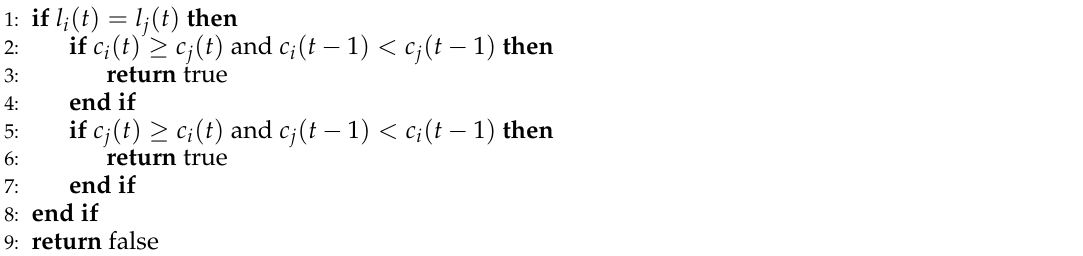
Algorithm 2 Detection of intersecting time-space